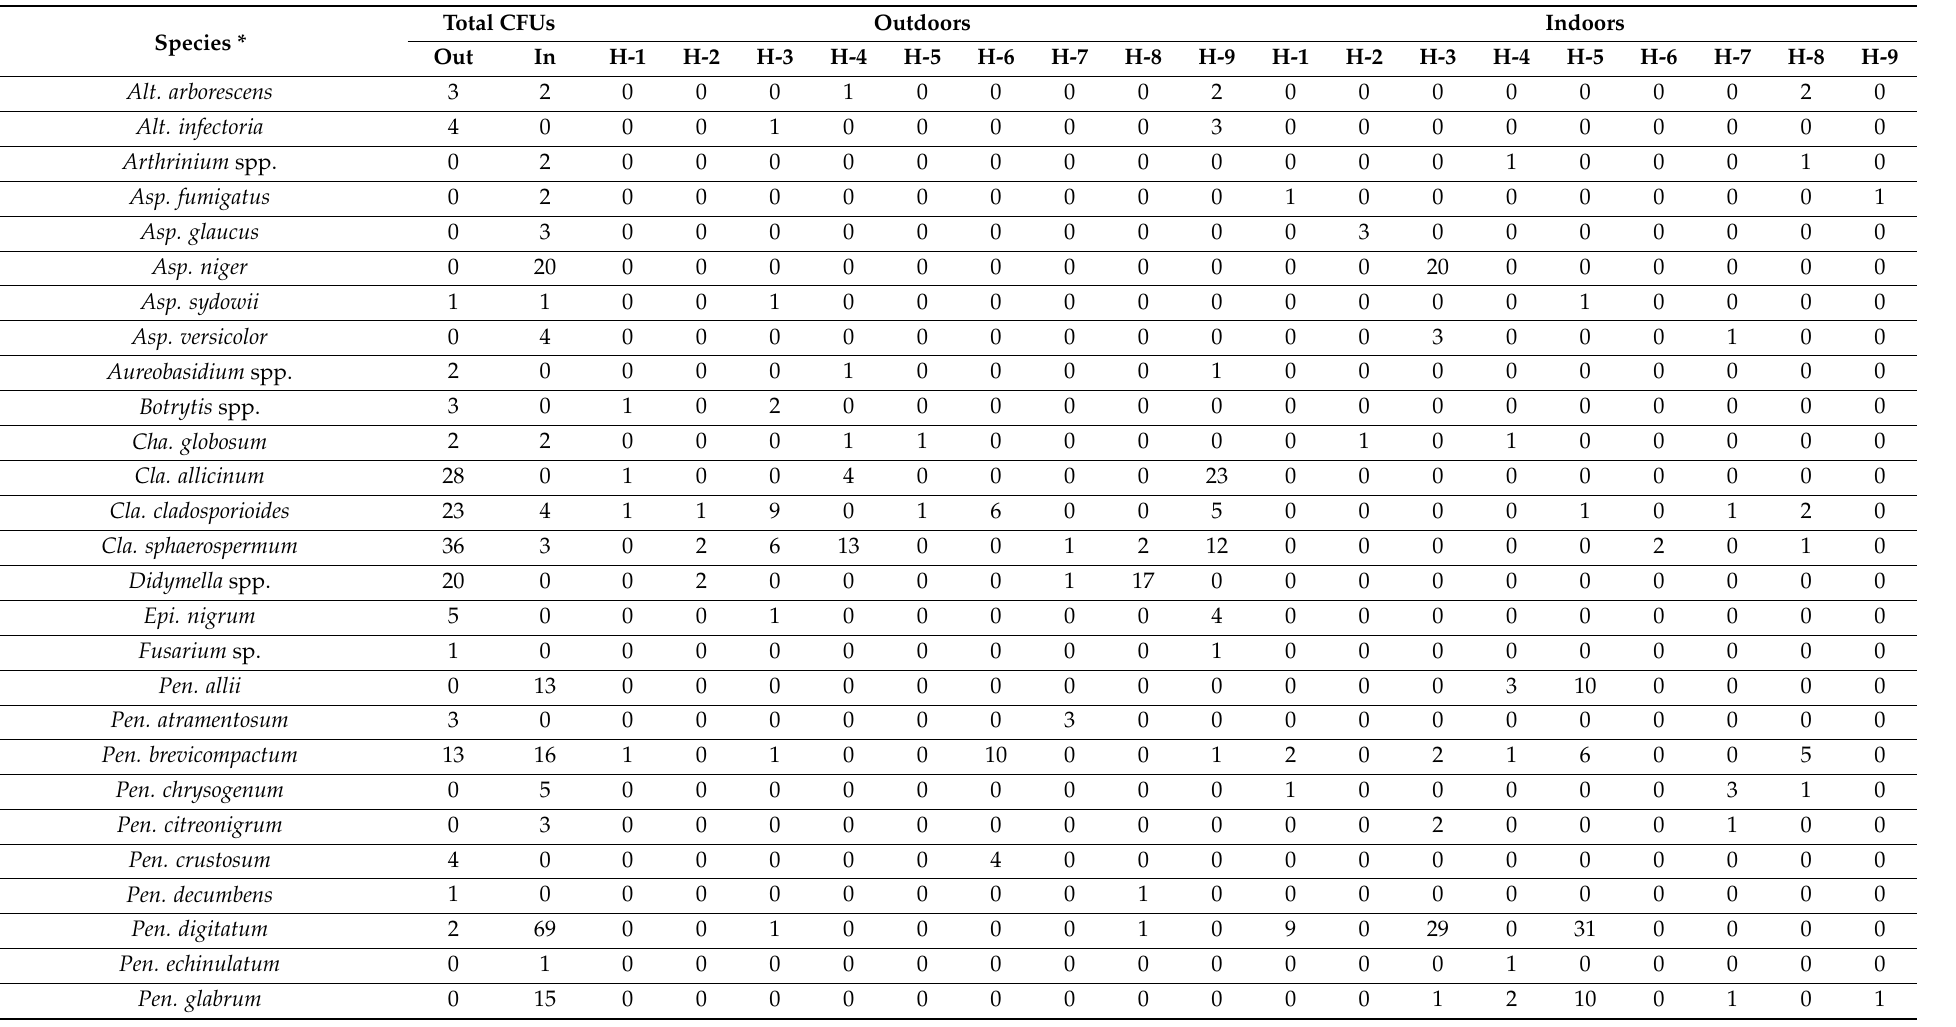
Table 5. Culture-dependent identification (DG18 and V8). Fungal species detected outdoors and indoors at the nine homes (H). Colony forming units (CFUs) counted and pooled from two DG18 and two V8 plates.